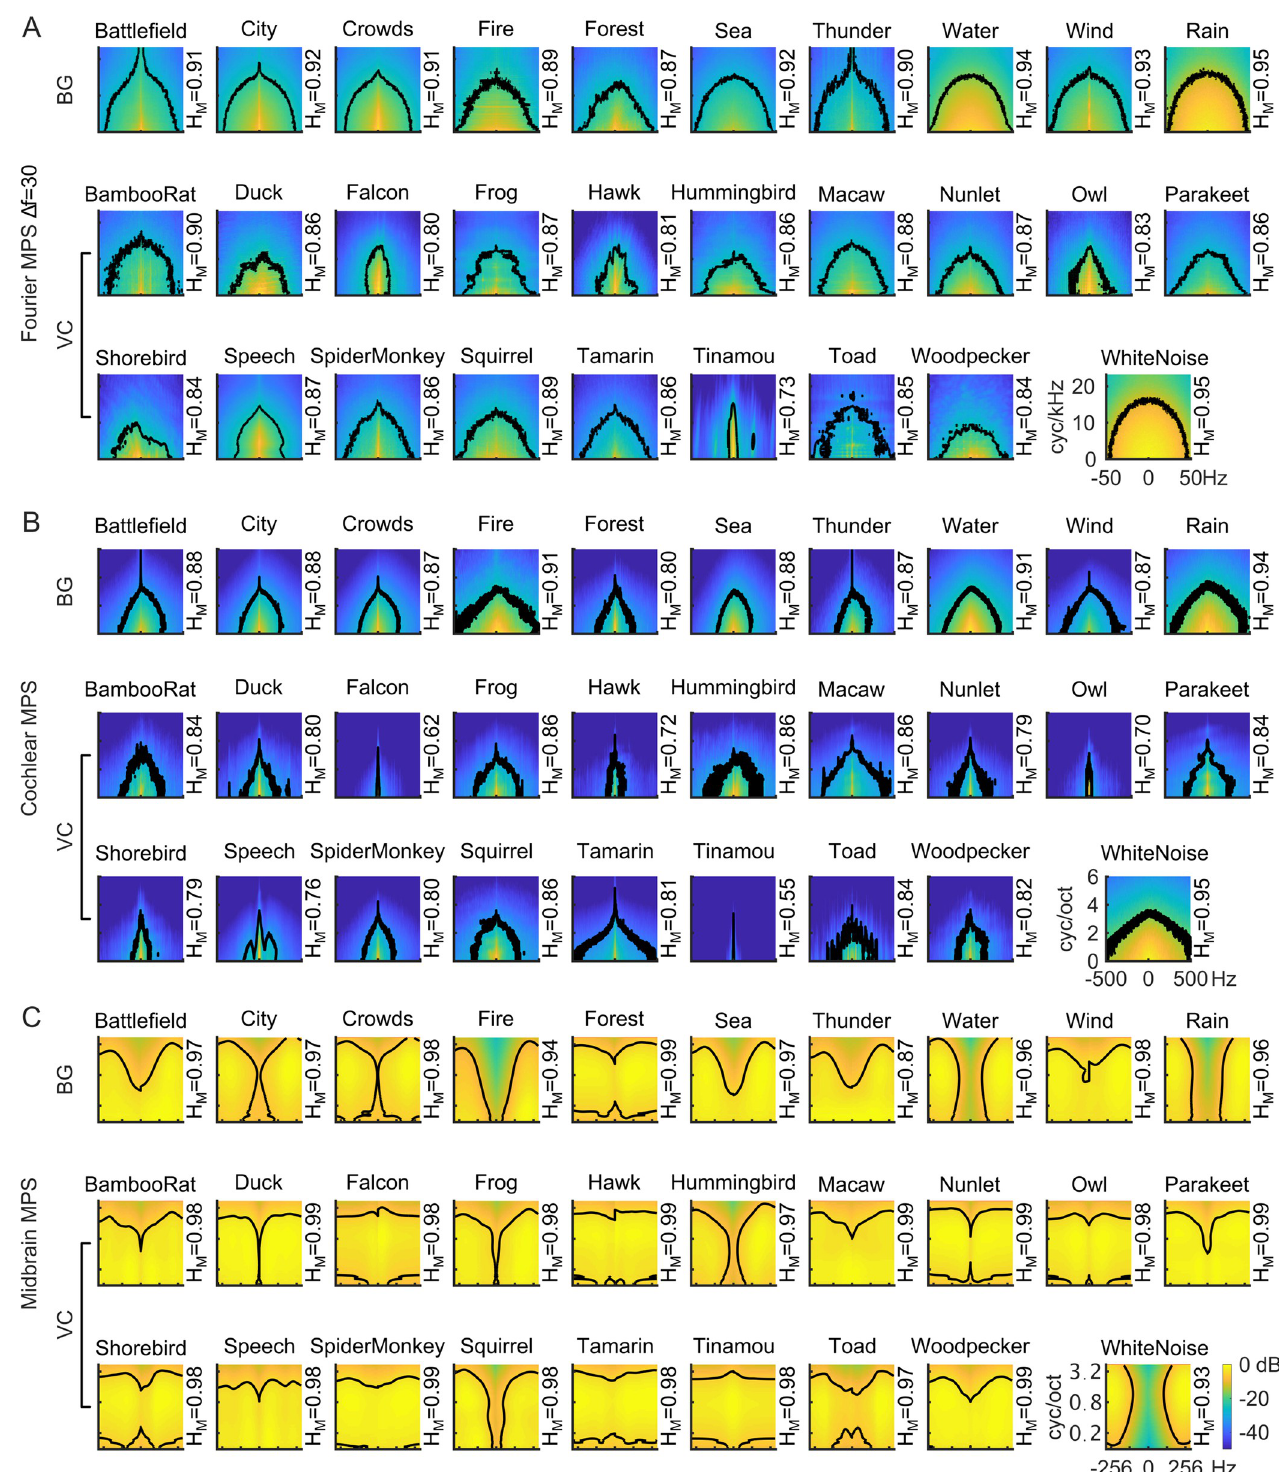
Fig 7. Modulation power spectra of natural sound ensembles including vocalizations (VC) and background sounds (BG). The modulation power spectrum is shown for the (A) Fourier-based decomposition ( Δ f = 30 Hz), (B) cochlear model decomposition and (C) midbrain model decomposition. Whereas the Fourier MPS and cochlear model MPS overemphasize low frequency spectral and temporal modulations, the midbrain model MPS is substantially flatter. Black contours in each graph designate the MPS region accounting for 90% of the total sound power. The modulation entropy of each sound category is listed on the right side of the